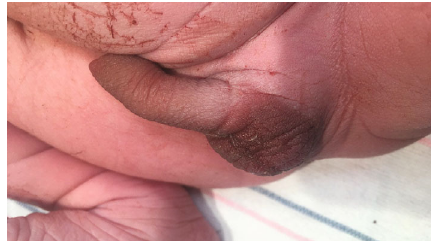
Figure 2: Note few rugae and undescended